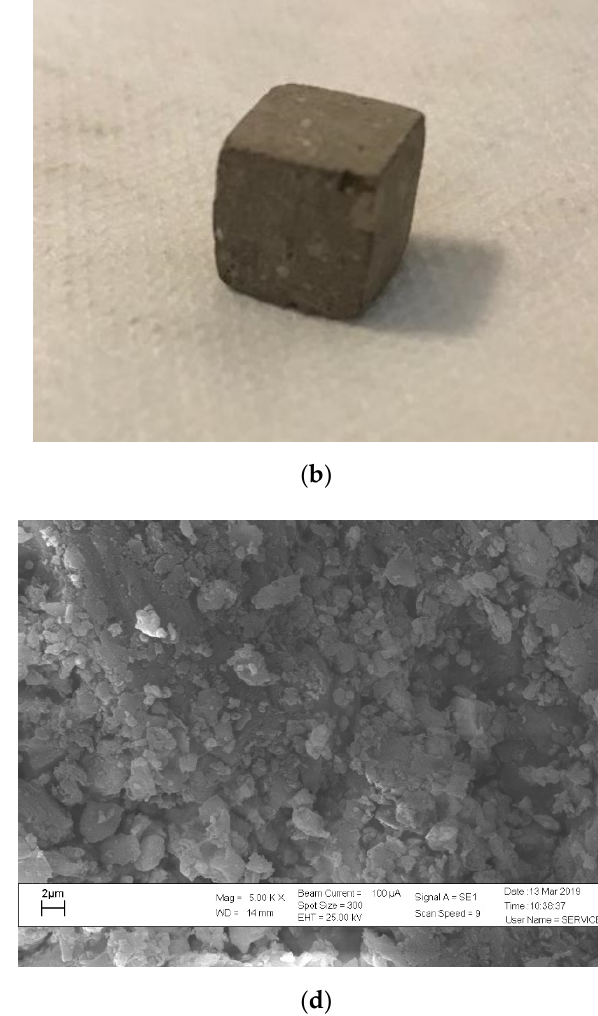
Figure 5. Soil with expansive clays from Lampa: ( a ) soil profile in extraction point; ( b ) sample prepared for microscopic analysis; ( c ) SEM image 1 k X; ( d ) SEM image 5 k X.